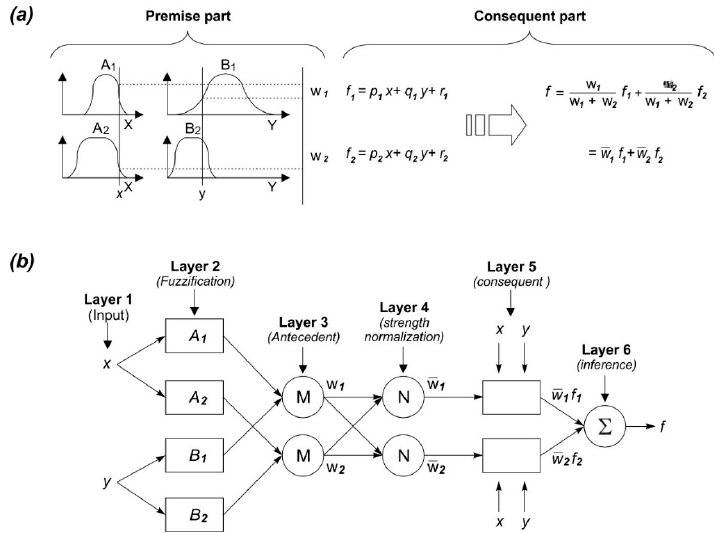
Figure 4. General ANFIS architecture of first order Takagi–Sugeno fuzzy model [65]: ( a ) Multi-layer perception fuzzy reasoning; ( b ) equivalent ANFIS structure.